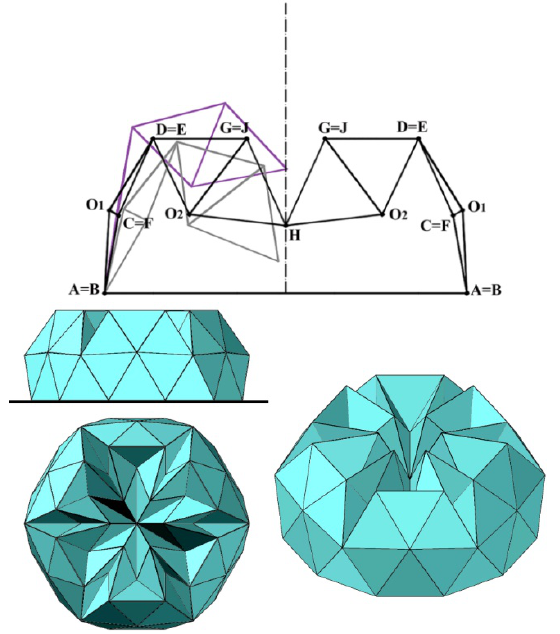
Figure 6. CP IV-12B(C * QO 2 ) - vertical section of three positions of a unit cell, orthogonal projections and spatial model